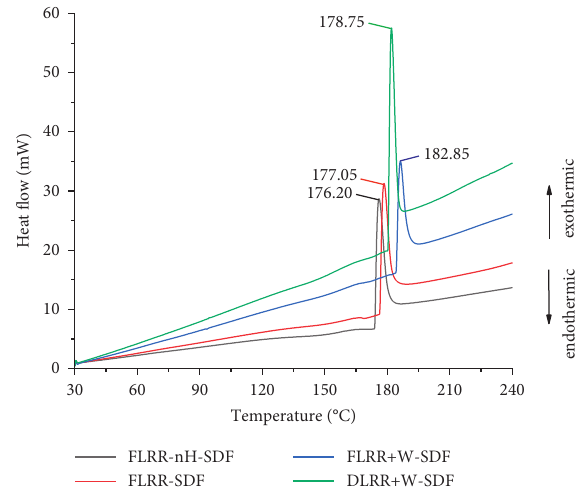
Figure 2: DSC curves of FLRR-nH-SDF, FLRR-SDF, FLRR+W- SDF, and DLRR+W-SDF from